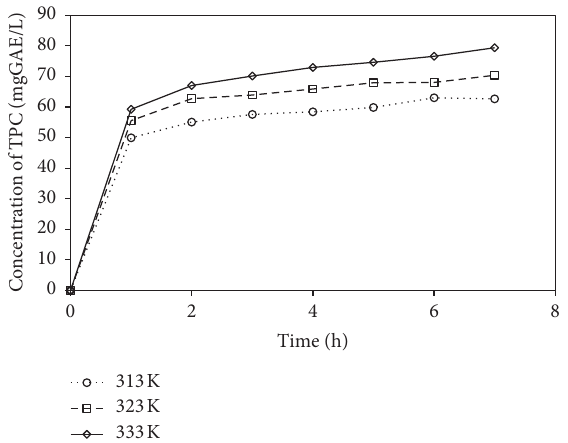
Figure 2: Effect of temperature on the concentration of TPC by batch extraction.